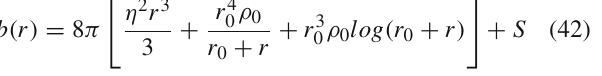
Fig. 12 NEC with respect to r ( kpc ) and η is plotted by using ρ 0 = 0.05 kpc − 2 , r 0 = 1 kpc , r th = 1 . 7 kpc , k 1 = k 2 = 1, α = 0 . 8, β = 0 . 001 and τ = 2 . 5 for NFW profile